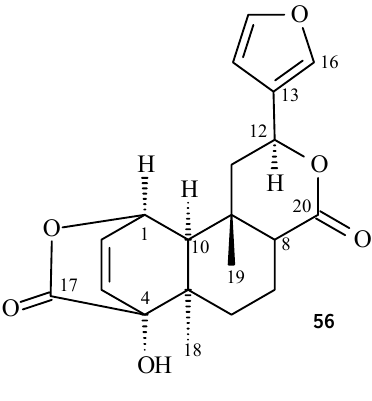
Figure 6. Furanoditerpene isolated from Aristolochia species.